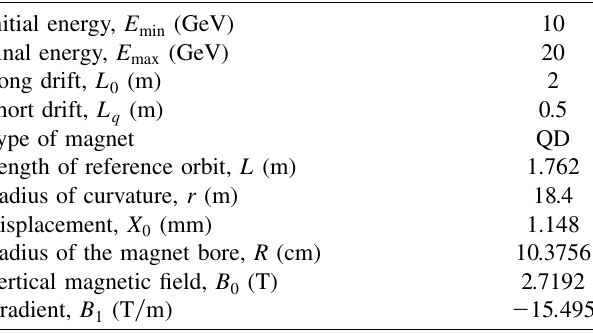
TABLE VIII. Parameters of the QD magnet: L the long drift between the QF magnets; L short drift between QF and QD magnets; X of the center of the magnet from the reference orbit (see Fig. 28); B is the vertical magnetic field at the reference orbit, and B 0 the derivative of the vertical magnetic field at the reference orbit.